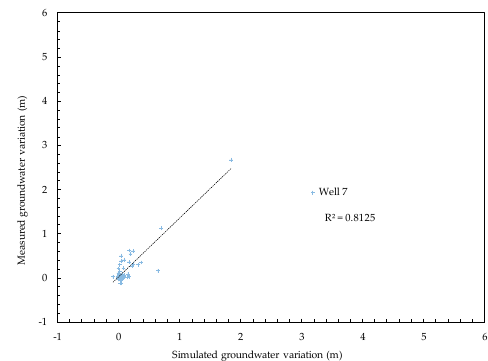
Figure 11. The model testing correlation relationship of Well 6.